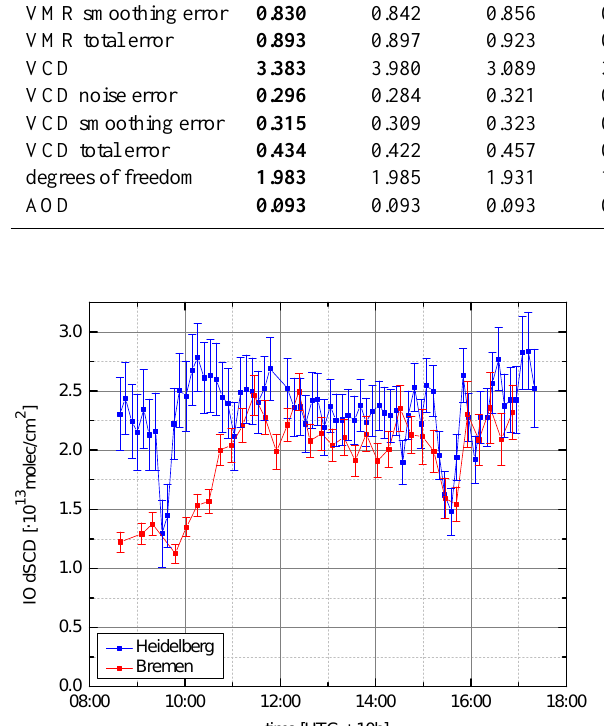
Fig. 6. Comparison of IO dSCDs retrieved from 5 ◦ elevation angle observations of the Bremen (red) and the Heidelberg (blue) instru- Fig. 6: Comparison of IO dSCDs retrieved from 5 ◦ elevation angle observations of the ments on 14 October 2009. Since the Bremen instrument performed Bremen (red) and the Heidelberg (blue) instruments on October 14, 2009. Since the Bre- more elevation angles per sequences, observations at specific eleva- men instrument performed more elevation angles per sequences, observations at specific tion angles are less elevation angles are less frequent.